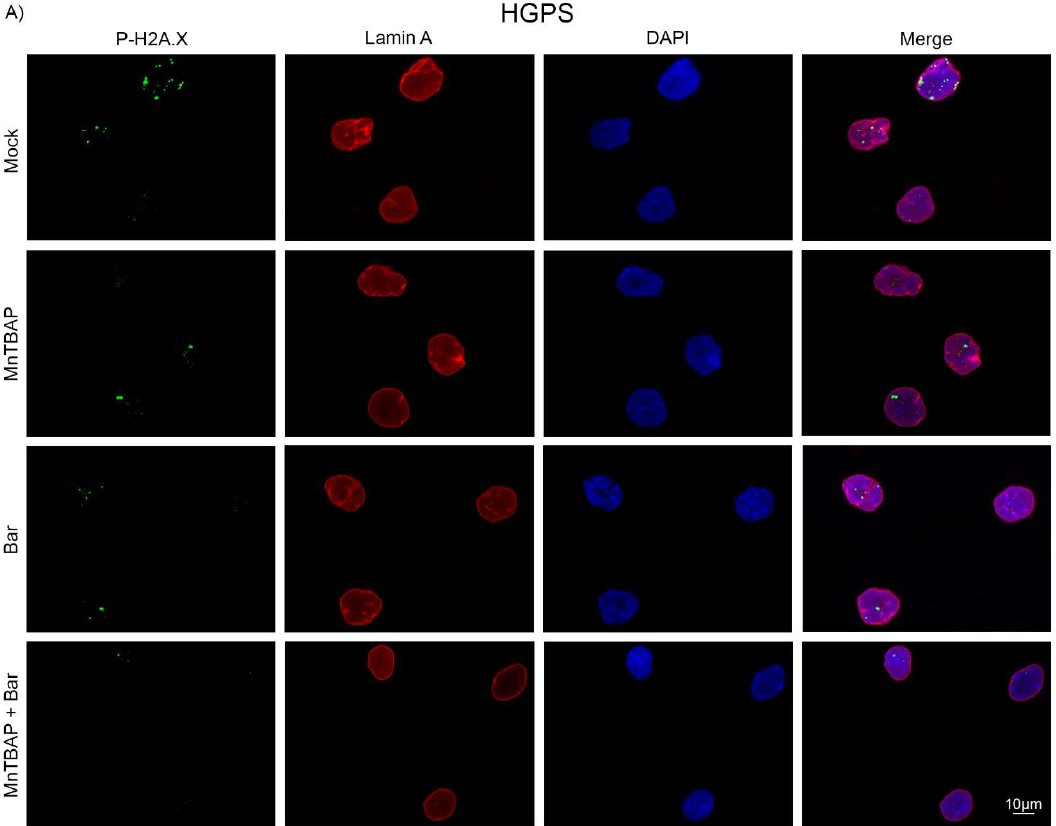
Figure 6. MnTBAP/Bar combination treatment reduces the number of p-H2A.X foci. ( A ) Representative immunofluorescence images of HGPS fibroblasts after 9 d with a mock solution, 5 µM MnTBAP, 1 µM Bar, or the MnTBAP/Bar combination. The cells were stained with anti-phospho histone H2A.X (Ser139) (green) and anti-lamin A (red) antibodies and counterstained with DAPI. ( B ) The number of nuclei with low DNA damage (black) or severe DNA damage (grey) after treatment was scored in at least 900 nuclei for each condition. Graphs show the mean ± SD ( n = 4; * p < 0.05, ** p < 0.01).